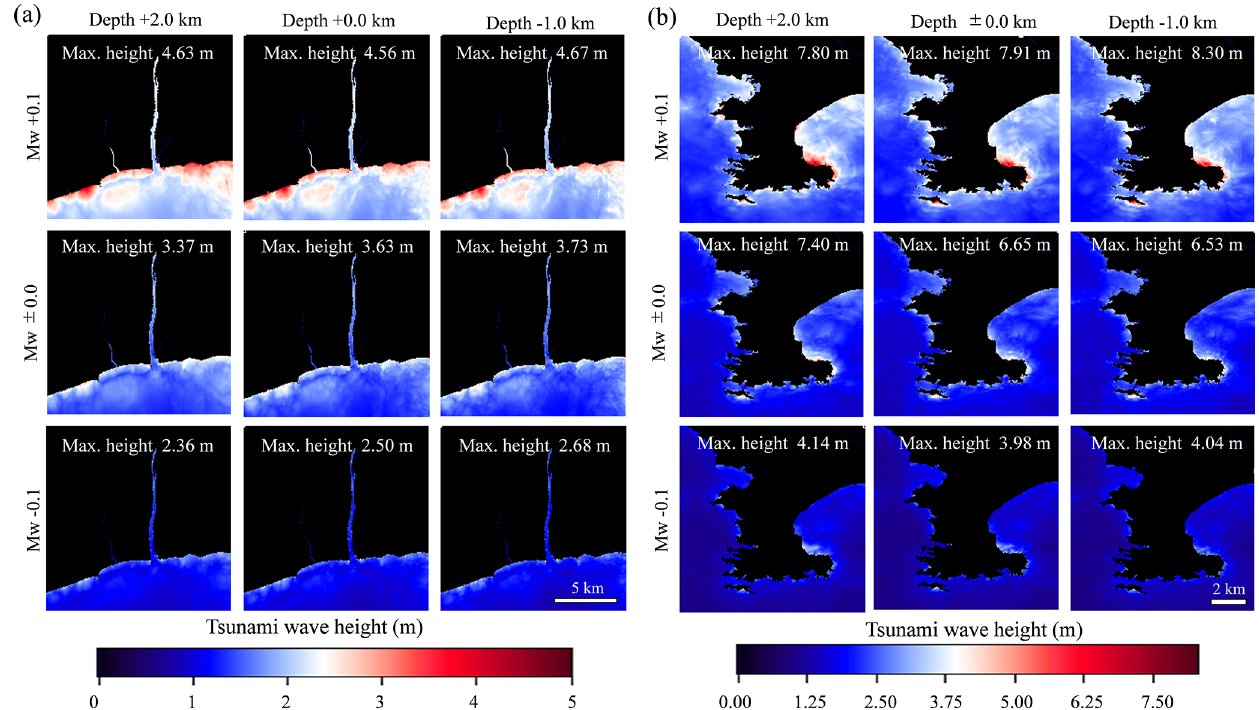
Figure 5. Tsunami numerical simulation results ( a Oiso and b Miura) in the case changing the M w (moment magnitude) and the fault depth of source 8.